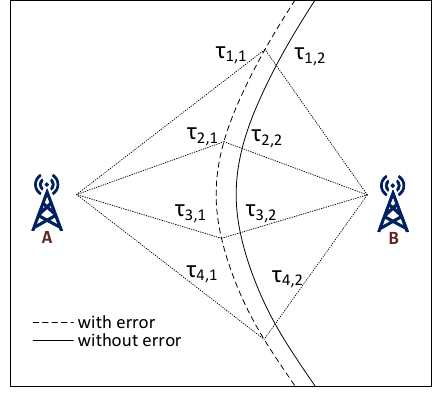
Figure 4. Time difference of arrival (TDoA)—hyperbolic trajectory